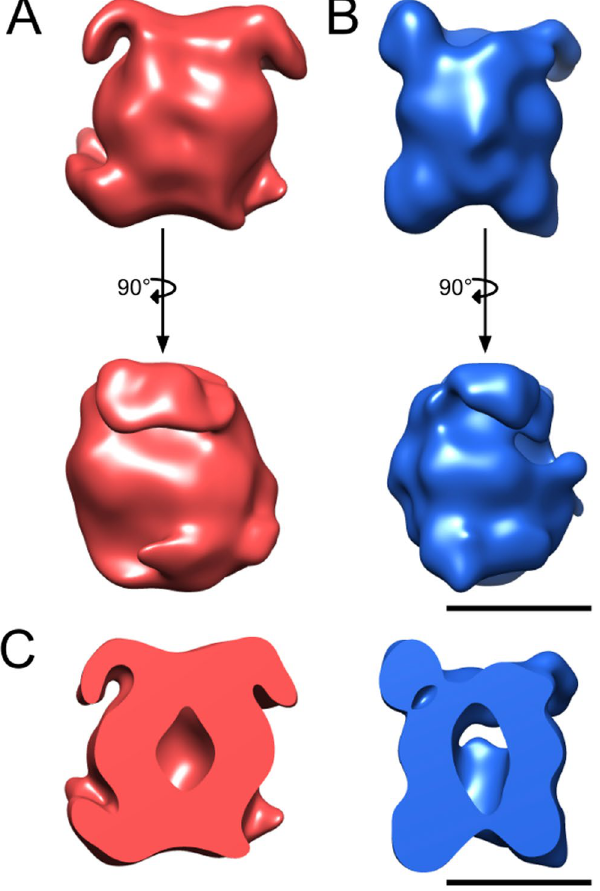
Figure 6. 3D reconstructions of the homodimeric 3xflag-LRRK2 and 3xflag-LRRK1 complexes. ( A ) 3D model of 3xflag-LRRK2 (red) at 24.2 Å resolution showing the side-view orientations, the lower one being 90 degrees rotated relative to the upper one. ( B ) 3D model of 3xflag-LRRK1 (blue) at 24.3 Å resolution showing two side- view orientations, the lower one being 90 degrees rotated relative to the upper one. ( C ) Cut-away of 3xflag- LRRK2 (red) and 3xflag-LRRK1 (blue). The plane of the slice is perpendicular to the presumed dimer axis. Scale bars: 10 nm.